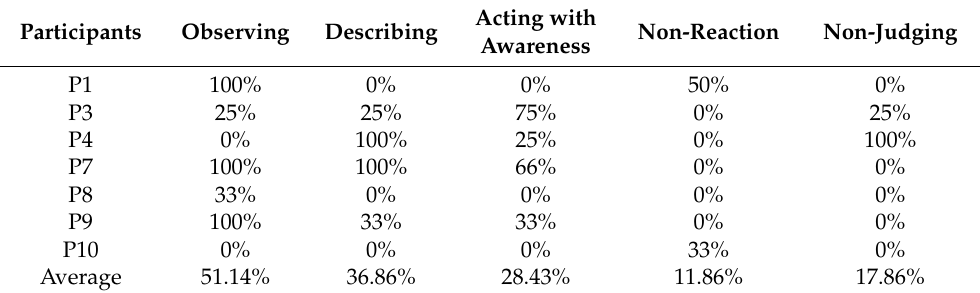
Table 5. Percentages of data exceeding the median recorded in FFMQ subscales.